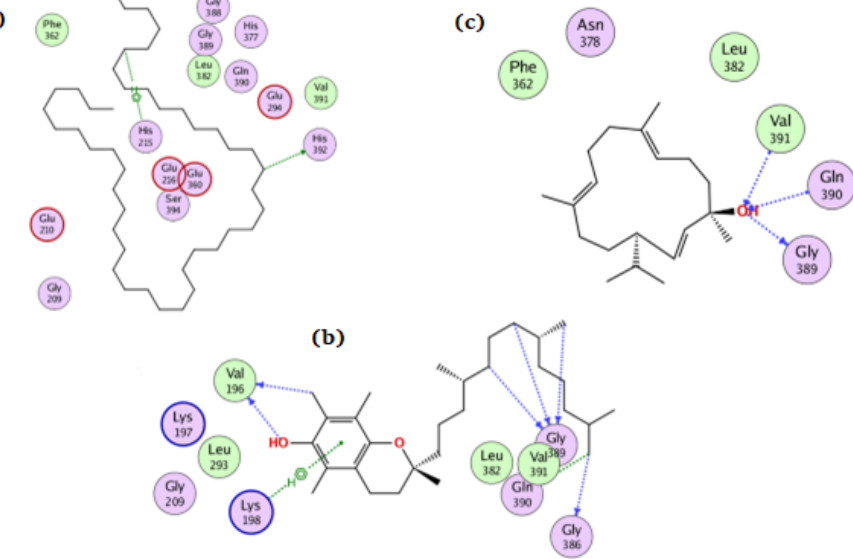
Figure 7. The docking of ( a ) tetratetracontane, ( b ) α -tocopherol, and ( c ) thunbergol on the active site of tyrosinase enzyme (PDB code: 5m8q).